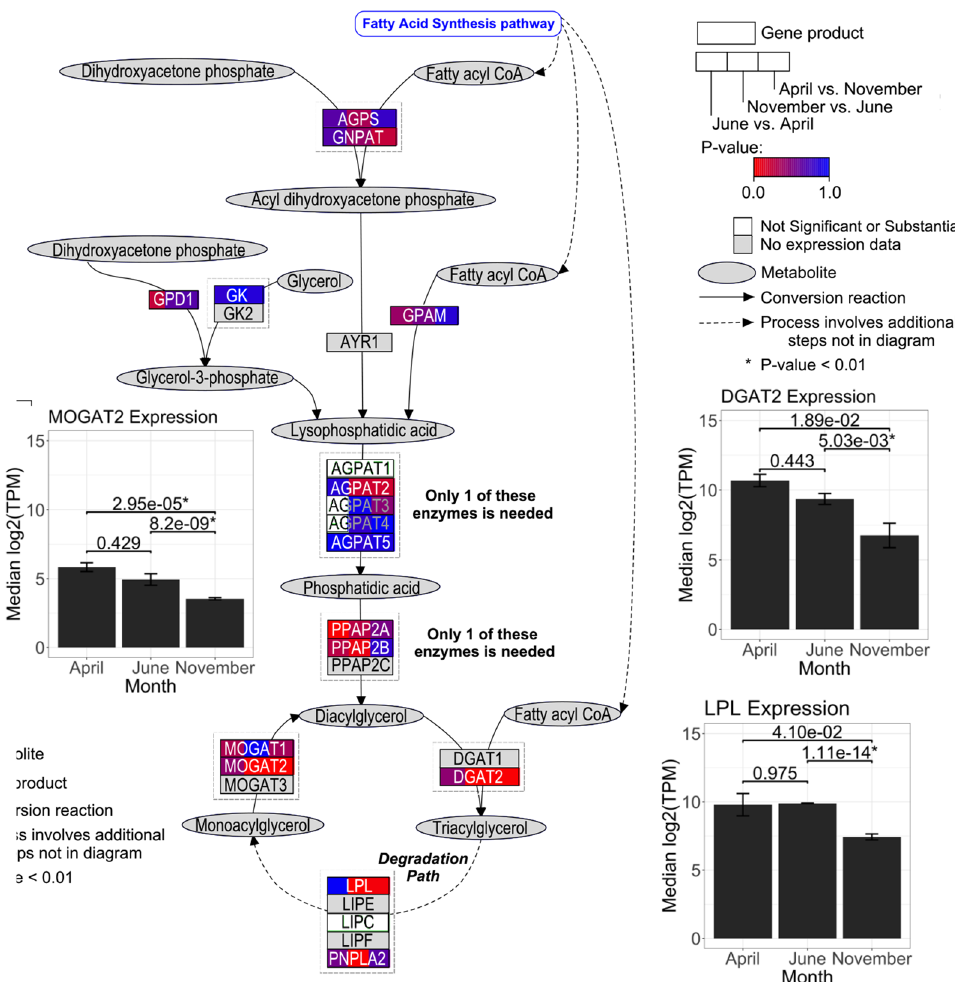
Figure 5. Triacylglycerol synthesis pathway and male seasonal differential expression. Emu triacylglycerol synthesis is represented by the Gallus gallus pathway. Gene products are coloured by their respective gene’s Benjamini–Hochberg corrected p-values from the male seasonal differential expression analysis. Three genes ( DGAT2 , LPL , and MOGAT2 ) have bar plots of expression levels. MOGAT2 was seasonally DE in males. Other figure details are the same as in Fig.